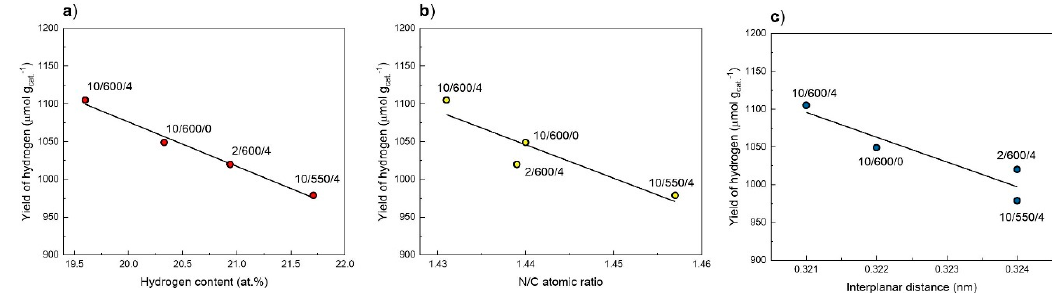
Figure 13. Correlation between the yield of hydrogen in the water-methanol photocatalytic oxidation under inert atmosphere and hydrogen content determined by EA ( a ), and N / C atomic ratio by EA analysis ( b ), and interlayer distance calculated form XRD patterns ( c ).